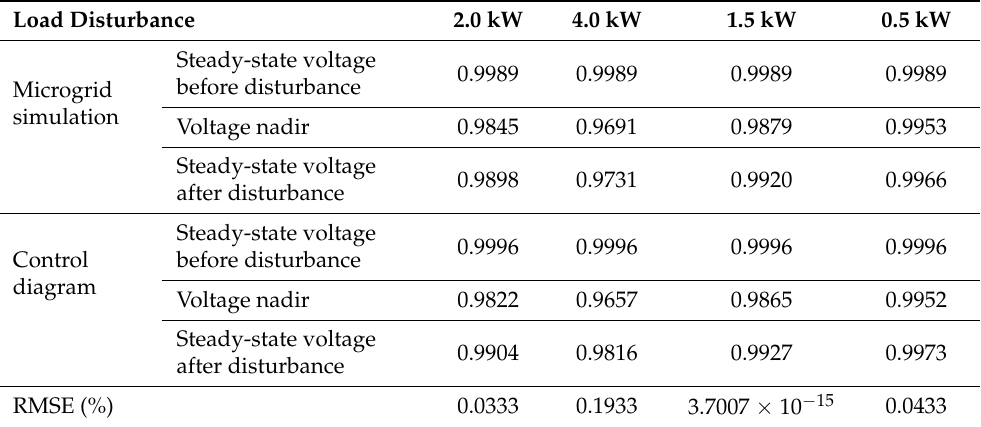
Table 5. The comparison of dynamics between simulation and control